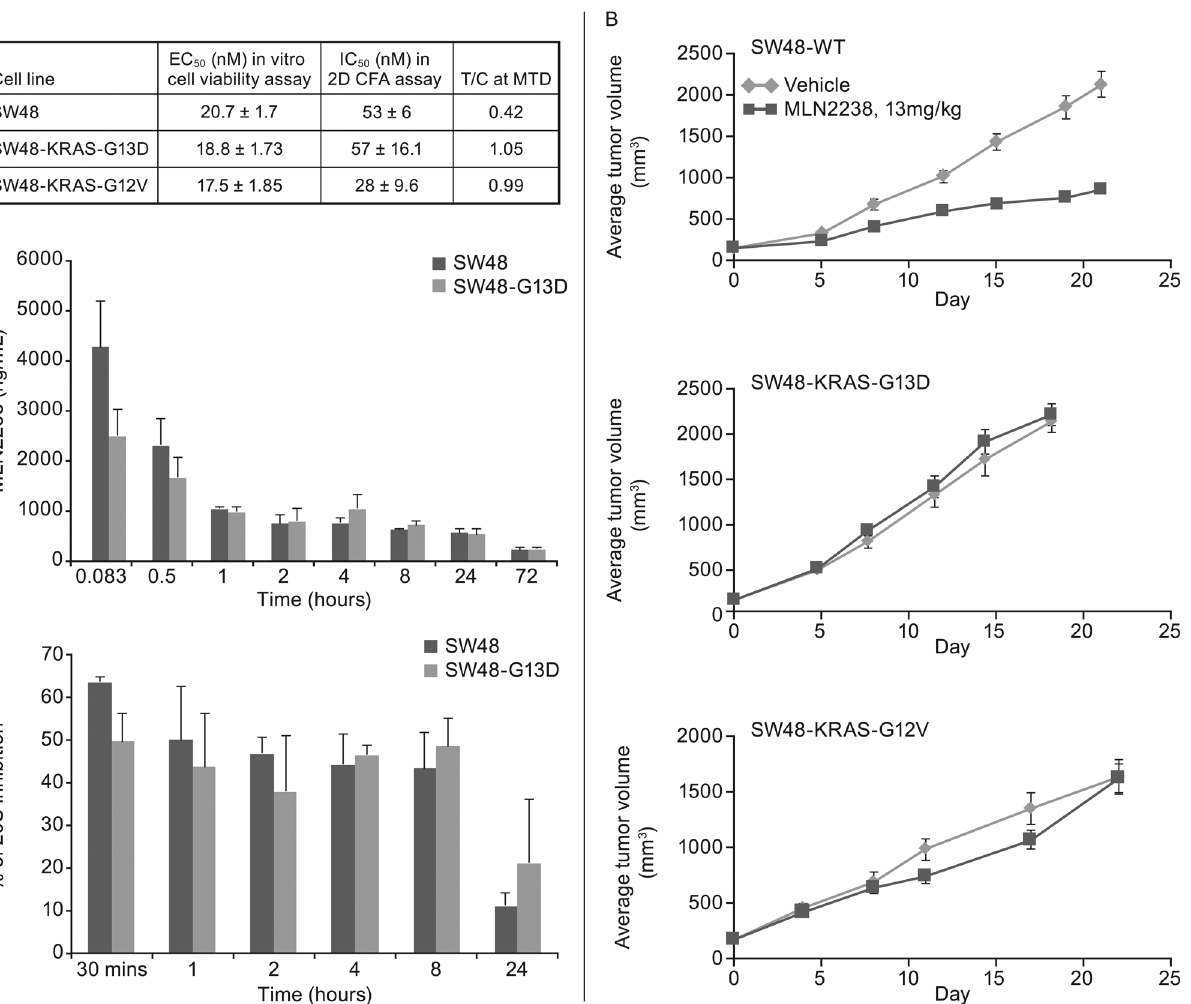
Fig 2. In vitro and in vivo activity of ixazomib in SW48 isogenic cells and xenografts. (A) Summary table of EC 50 , IC 50 and T/C values for SW48, SW48-G13D and SW48-G12V cells and xenografts from in vitro cell viability, in vitro colony formation and in vivo antitumor activity assays. EC 50 represents the mean concentration of ixazomib (+/-SD) required for 50% cell killing in three different experiments in cell viability assay. In the colony formation assay (CFA) the mean concentration of the drug to inhibit 50% colony formation was calculated in three different experiments and the number is mean +/-SD. 13mg/ kg, IV, BIW dose was used in xenograft studies and T/C was calculated as described before. (B) Antitumor activity of ixazomib in SW48, SW48-G13D and SW48-G12V xenografts. The tumor growth over time is presented for vehicle and ixazomib treated animals bearing SW48, SW48-G13D and SW48-G12V xenografts. The treatment started when average tumor volume reached approximately 200mm 3 and there were n = 10 animals per arm. The T/C was calculated at day 19 – 21. C and D: Tumor concentration of ixazomib (C) and 20S proteasome inhibition (D) at different time points following an acute IV administration of ixazomib at 13mg/kg dose in SW48 and SW48-G13D tumors. Each data point represents tumors from three different animals +/-